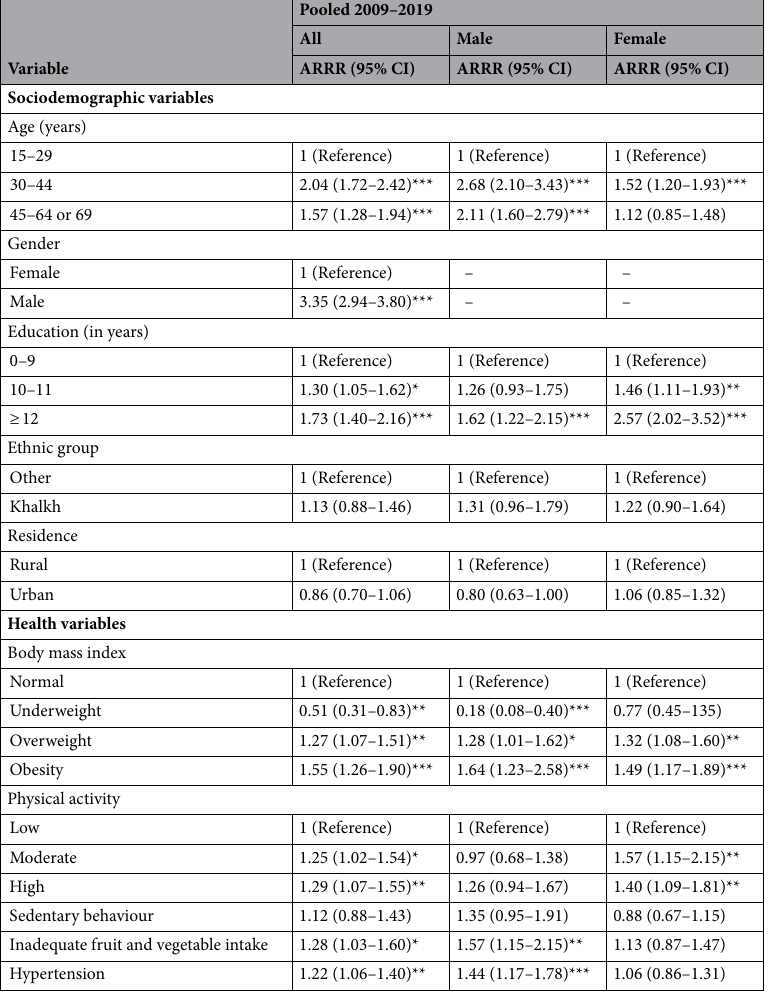
Table 15. Associations with current heavy drinking only (with non-current tobacco and non-current heavy drinking as reference category) among 15 years and older individuals in Mongolia, 2009–2019. *** p <